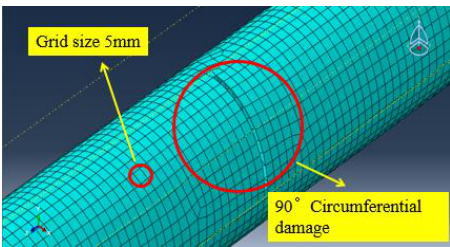
Figure 17. The pipe model meshing with 90° circumferential damage.